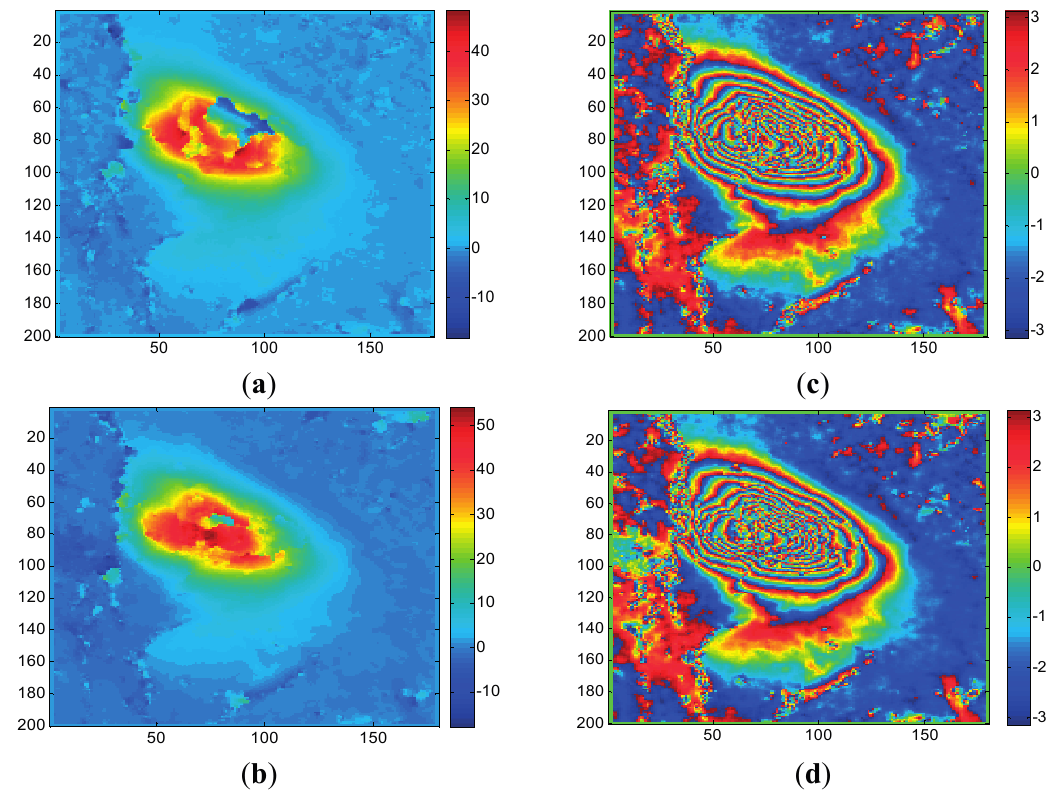
Figure 5. Unwrapped maps (left) and rewrapped maps (right) based on MC and PDV: ( a ) unwrapped map of MC; ( b ) unwrapped map of PDV; ( c ) rewrapped map of MC; ( d ) rewrapped map of